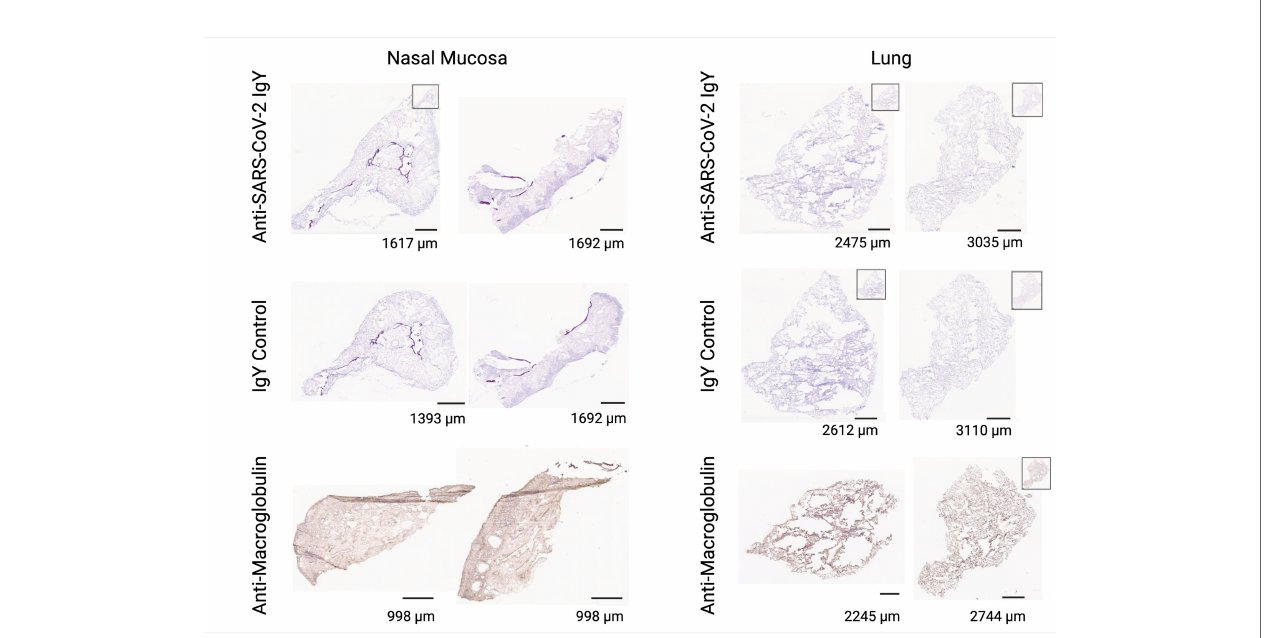
FIGURE 6 | Lack of cross-reactivity of anti-SARS-CoV-2 RBD IgY with human tissues. Immunohistochemical testing of anti-SARS-CoV-2 RBD IgY (top row), control IgY (middle row; negative control), and anti-human macroglobulin antibodies (bottom row; positive control) with human nasal mucosa (left two panels) and human lungs (right two panels). Bars provide a magni fi cation